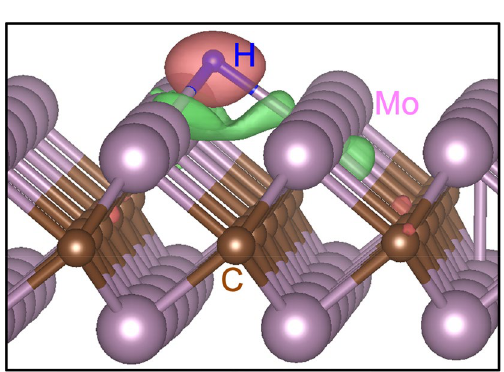
Figure 4. The charge redistribution in the formation of the H–Mo bonds. The redistribution is calculated by Mo 2 C ( r ) H ( r ) subtracting charge densities of the isolated Mo 2 C ρ and H atom ρ from that of the H absorbed Mo 2 C H ( r ) Mo 2 C H ( r ) ρ Mo 2 C ( r ) ρ H ( r ) Mo 2 C ρ , i.e., ρ . The red and green iso-surfaces denote increasing + + ] − [ + and decreasing of the charge density in the bond formation,